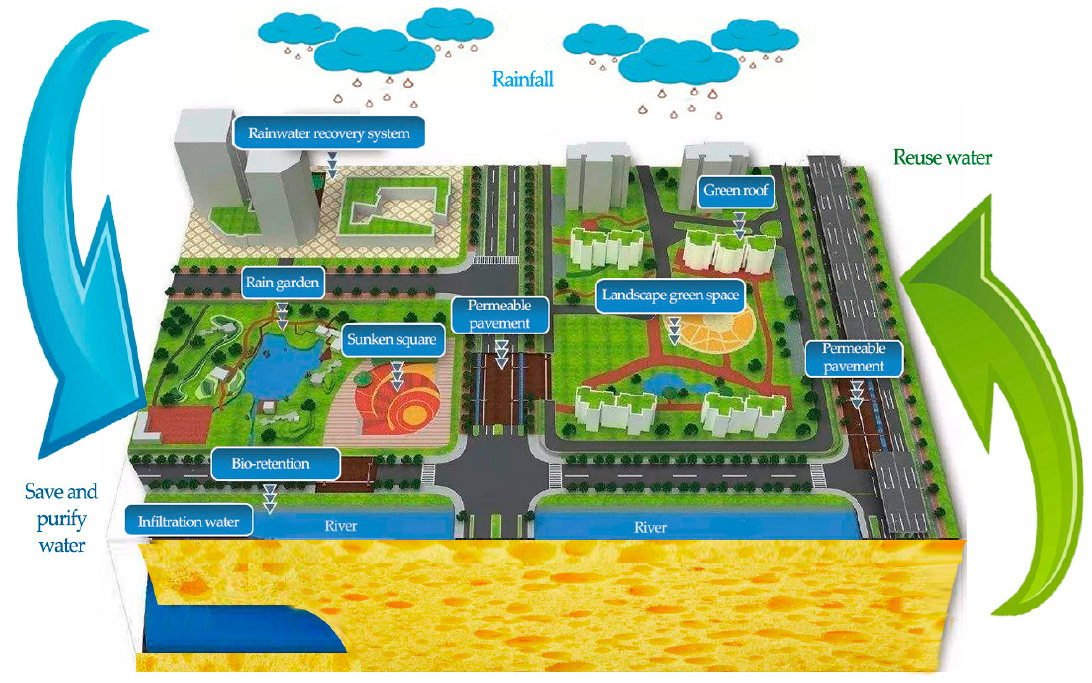
Figure 1. Sketch of sponge city.